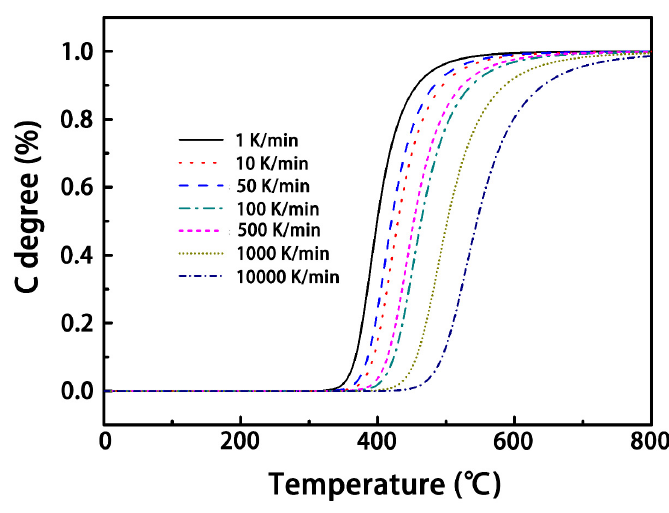
Figure 2. Degree of pyrolysis versus temperature at different heating